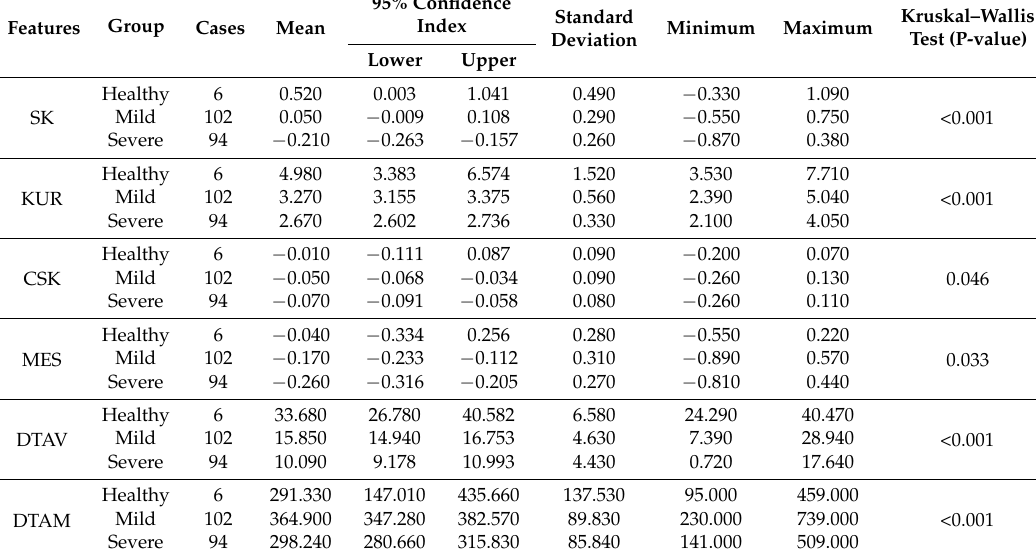
Table 2. The descriptive statistical and Kruskal–Wallis test results between healthy, mild (HYS Stage 1 to Stage 3), and severe (HYS Stage 4 and Stage 5) (n =